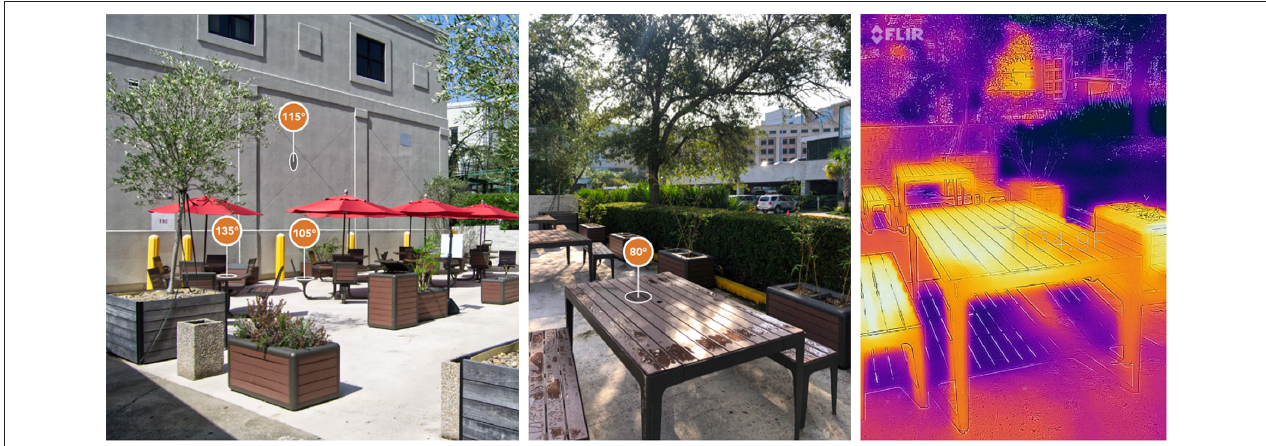
FIGURE 5 | Charleston Medical District skin surface temperature